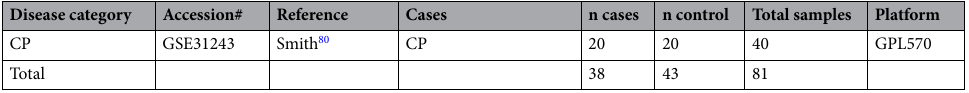
Table 1. Summary of public gene expression-based discovery and validation data sets used in the meta- analysis. IM inflammatory myositides, MMD myotonic muscular dystrophy, MD muscular dystrophies, DMD Duchene’s muscular dystrophy, FSHD fascioscapulohumoral muscular dystrophy, LGMD2A limb- girdle muscular dystrophy type 2A, HIBM heritable IBM, POLG1, MD, TMD tibial muscular dystrophy, IBM inclusion body myositis, DM diabetes mellitus, GSD II glycogen storage disease type II, also called Pompe disease, POLG1 mitochondrial DNA polymerase γ, ICUAW intensive care unit acquired weakness, MODS multi-organ dysfunction syndrome. a Not published yet. b Deltoid muscle samples removed as FSHD typically affects biceps. c Same healthy controls used in subcohorts of GSE3307.